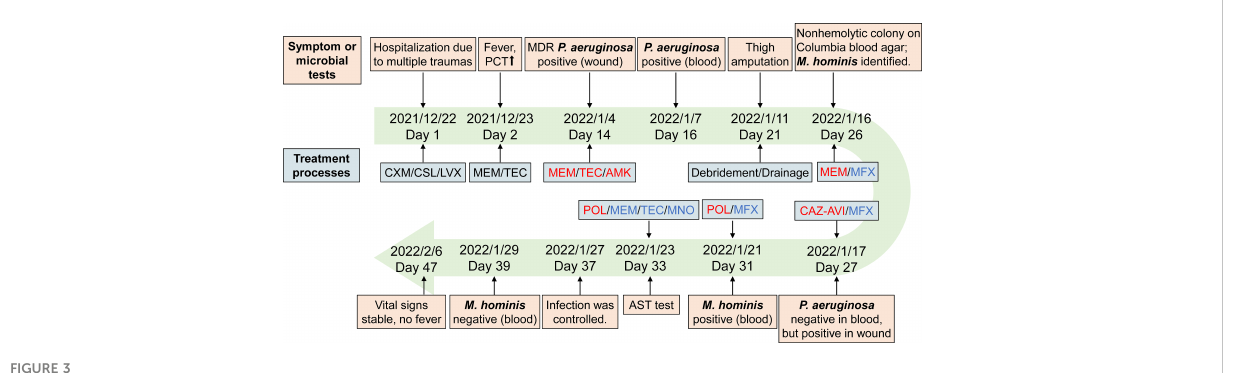
FIGURE 3 Timelines of patient ’ s diagnosis and treatment. Red, the anti-infective drugs for P. aeruginosa . Blue, the anti-infective drugs for M. hominis . Abbreviations: CXM, cefuroxime; CSL, cefoperazone-sulbactam; LVX, levo fl oxacin; MEM, meropenem; TEC, teicoplanin; AMK, amikacin; MFX, moxi fl oxacin; CAZ-AVI, ceftazidime – avibactam; POL, polymyxin B; MNO,